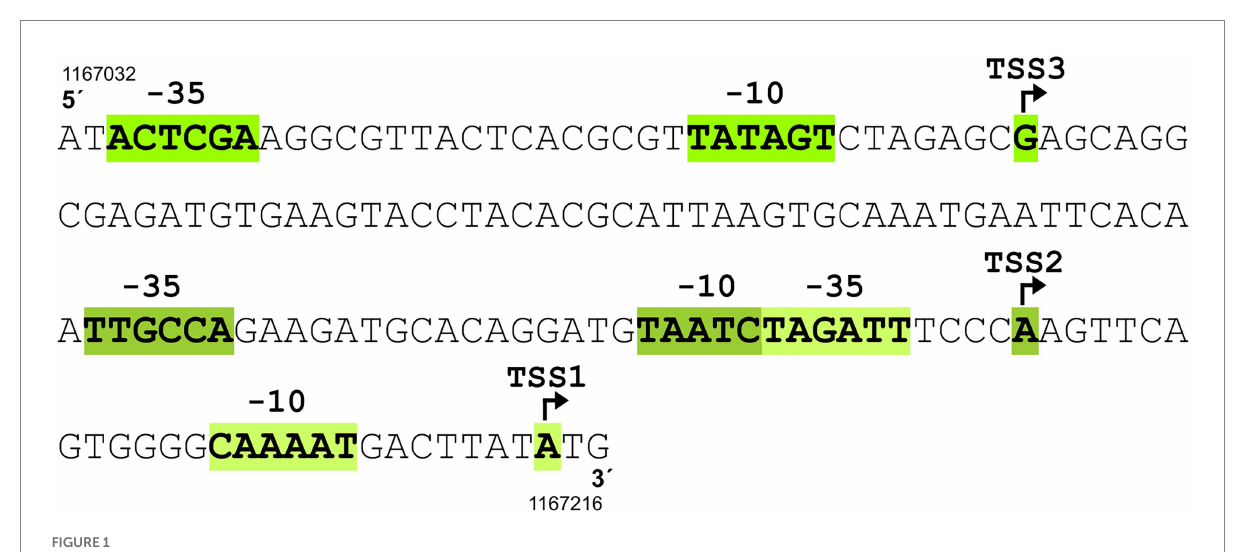
FIGURE 1 Upstream region of sigE gene containing three promoters (P1 sigE , P2 sigE, and P3 sigE ) driving transcription from transcriptional start sites TSS1, TSS2, and TSS3. The TSSs were detected by primer extension analysis. The sequences of the corresponding putative − 10 elements CAAAAT (P1 sigE ), TAATCT (P2 sigE ), and TATAGT (P3 sigE ) suggest that all three promoters are controlled by σ Α . Of the three potential − 35 hexamers, only TTGCCA belonging to P2 sigE conforms to the − 35 consensus TTGACA, whereas the other two share little similarity to the consensus. TSS are indicated by bent arrows. Genomic coordinates of the 5 ′ -end and 3 ′ -end of the C. glutamicum ATCC 13032 sequence according to GenBank RefSeq BX927147 are